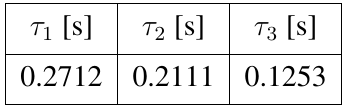
Table 1: Transit times from Ringhals-1 (from [3])